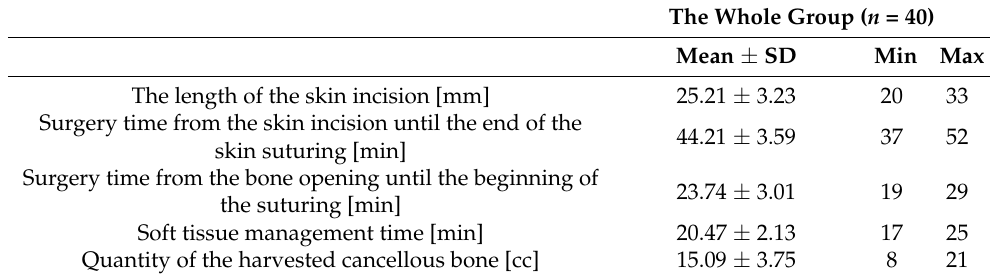
Table 1. Descriptive statistics of selected intraoperative parameters obtained during the procedure of cancellous bone harvesting from the proximal tibia in the general group of patients. The Whole Group ( n = 40) Mean ± SD Min Max The length of the skin incision [mm] 25.21 ± 3.23 20 33 44.21 ± 3.59 37 52 skin suturing [min] 23.74 ± 3.01 19 29 20.47 ±